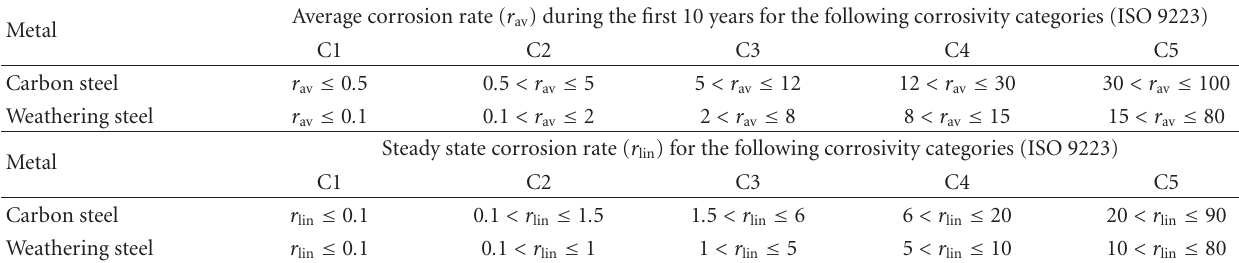
Table 1: Guiding corrosion values for corrosion rates ( r av , r lin ) of carbon steel and weathering steel in atmospheres of various corrosivity